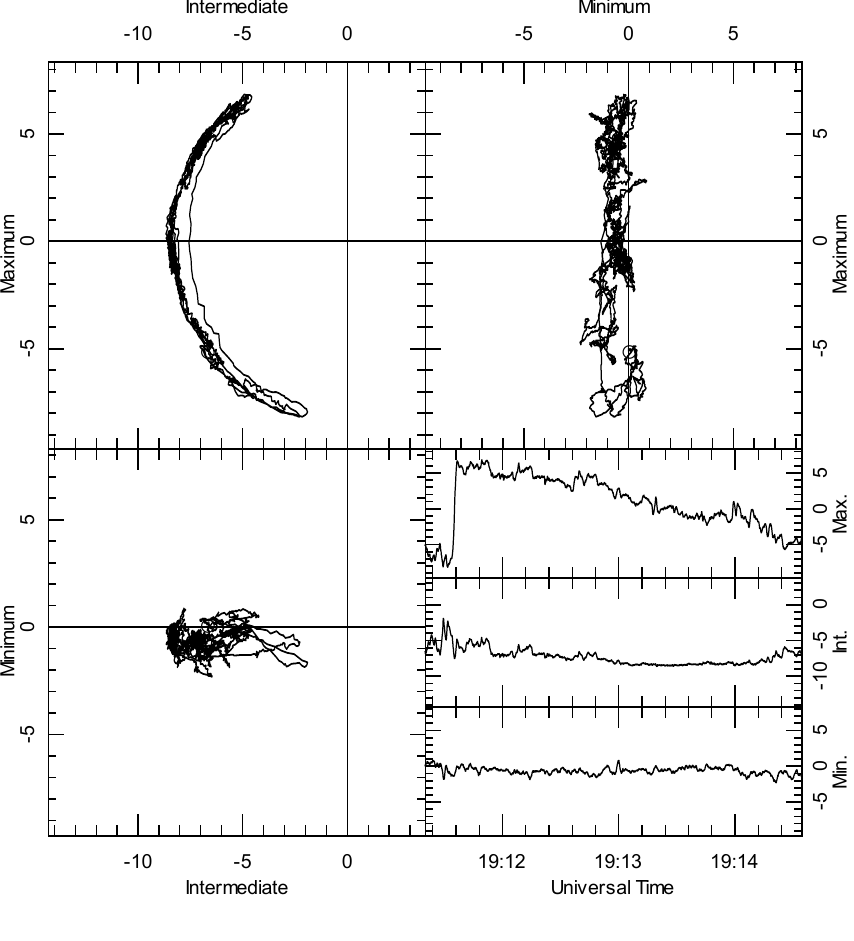
Fig. 1. Magnetic hodogram for Cluster 1 double-arc polarized event, seen in the solar wind on 3 February 2003, at (16.85;9.15; − 1.77) R E (GSE). Hodogram curve starts at small circle. It is shown in three projections, using as axes the right-handed orthonormal eigenvector triad ( ˆ x 1 ; ˆ x 2 ; ˆ x 3 ) (the principal axes) from variance analysis of the magnetic field (MVAB). Here ˆ x 1 = ( 0 . 9336 ; 0 . 2936 ; 0 . 2057 ) (GSE) is the minimum variance direction, with variance λ 1 = 0 . 26nT 2 ; ˆ x 2 = ( 0 . 0599 ; 0 . 4380 ;− 0 . 8970 ) is the intermediate variance direction, with λ 2 = 1 . 41nT 2 ; and ˆ x 3 = ( − 0 . 3534 ; 0 . 8497 ; 0 . 3914 ) is the maximum variance direction, with λ 3 = 14 . 50nT 2 . Note that our ordering of the eigenvectors differs from that used by Sonnerup and Scheible (1998). Time series of field components along the principal axes are shown in the bottom right panel. Note the saw-tooth like behavior of the curve for the maximum-variance component. Time resolution is 22.4